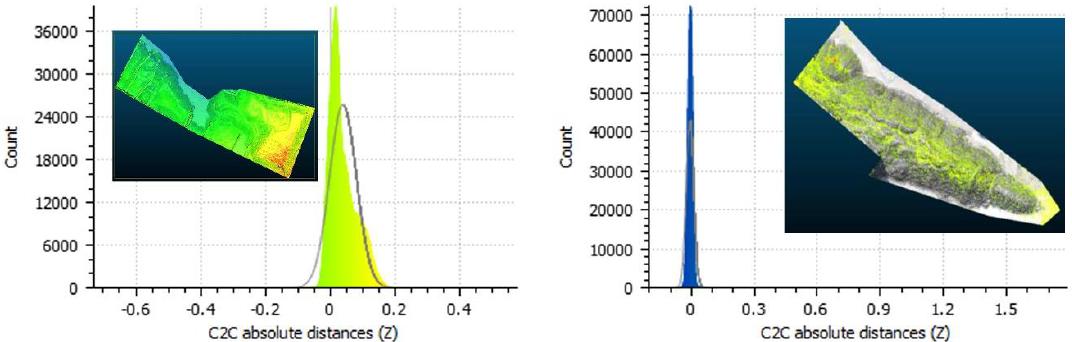
Figure 26. Statistics of the comparison of the clouds: stockpiles “0–7” ( left ), stockpile “8” ( right ).